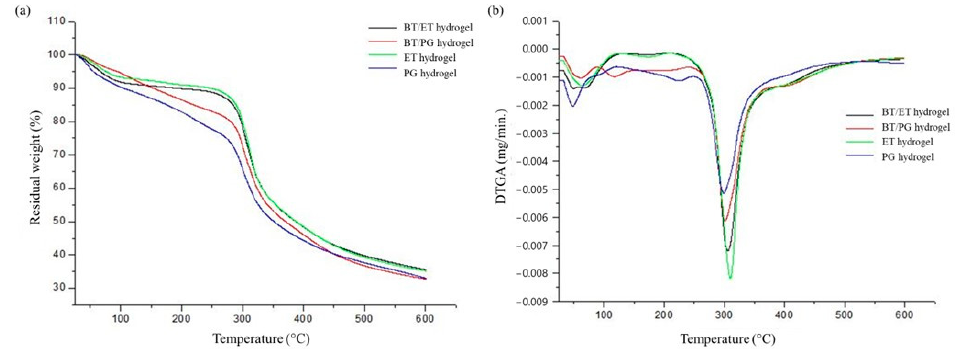
Figure 5. ( a ) Thermogram and ( b ) first derivative thermograms (DTGA) of the hydrogels.